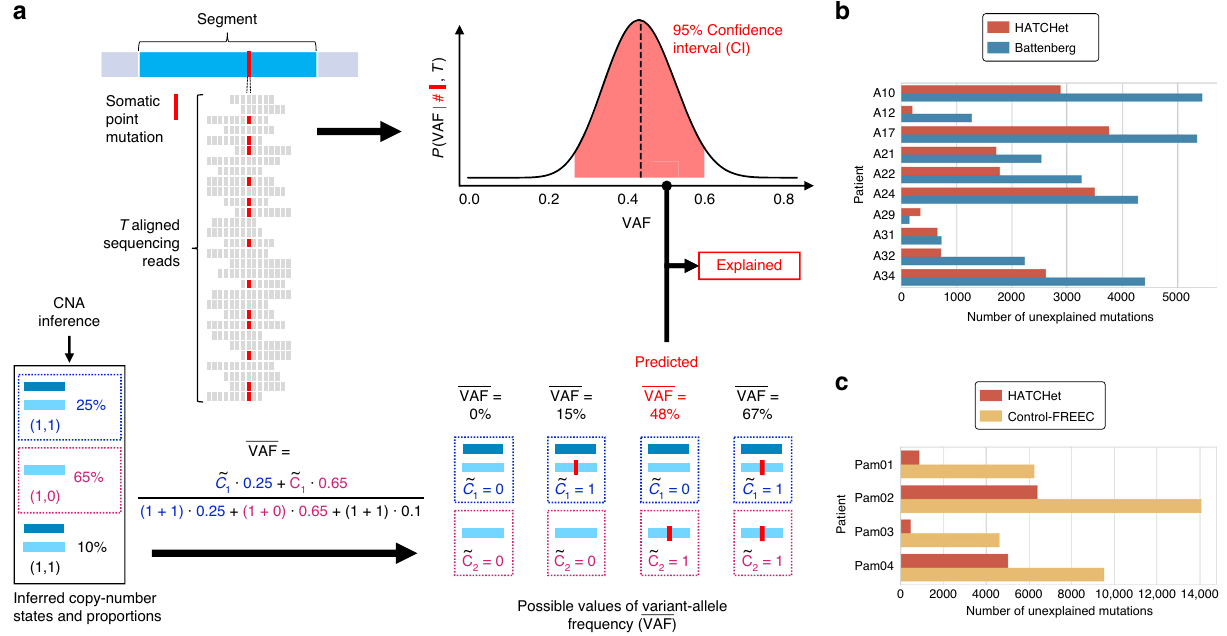
Fig. 6 HATCHet infers copy-number states and proportions that better explain VAFs of somatic SNVs and small indels. a A genomic segment (cyan rectangle) harbors a somatic mutation, which corresponds to either a somatic SNV or small indel. Reads with variant allele (red squares) and reference allele (gray squares) are used to estimate the VAF. (Top right) From T sequencing reads (gray rectangles) covering the mutation, a 95% con fi dence interval (CI, i.e., red area of posterior probability) on the VAF is obtained from a binomial model. (Bottom) Separately, copy-number states and proportions ; ~ c are inferred for this genomic segment. Given the numbers ~ c of mutated copies in each of the two copy-number states, the VAF of the mutation is 1 2 computed as the fraction of the mutated copies weighted by the proportions of the corresponding copy-number states. Assuming that an allele-speci fi c position is mutated at most once during tumor progression (i.e., no homoplasy), all possible values of VAF are computed according to the possible values of ~ c 1 and ~ c 2 . A mutation is explained if at least one value of VAF is within CI. b Over 10,600 mutations identi fi ed per prostate cancer patient on average, HATCHet copy numbers (red) yield fewer unexplained mutations than Battenberg (blue) in all patients but A29, where the difference is small. c Over 9,000 mutations identi fi ed per pancreas cancer patient on average, HATCHet copy numbers yield fewer unexplained mutations in all patients than